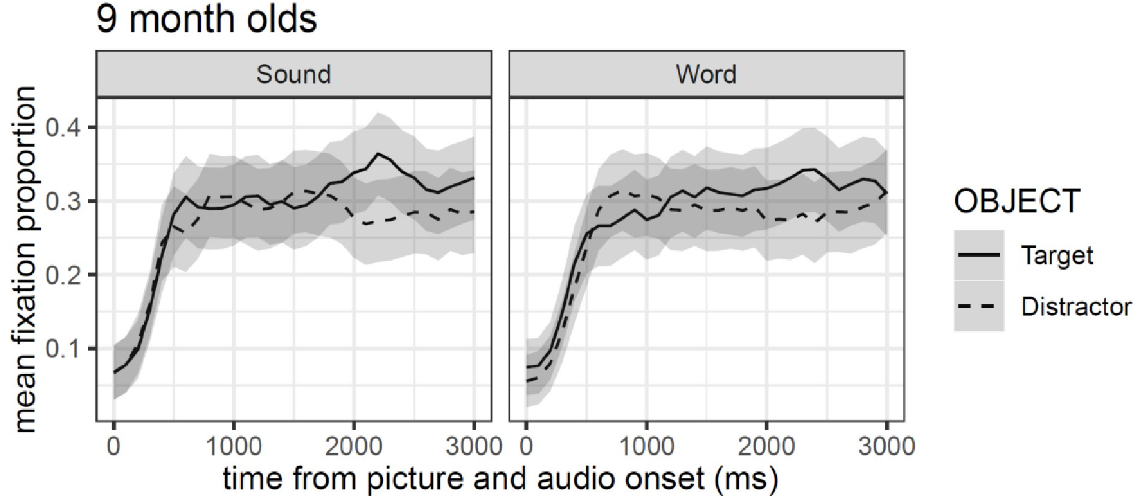
Fig 5. Mean fixation proportion (aggregated by participants) as a function of object in the visual context and type of auditory stimulus. Shaded areas around lines represented 95% confidence intervals adjusted for within-subject designs and multiple time